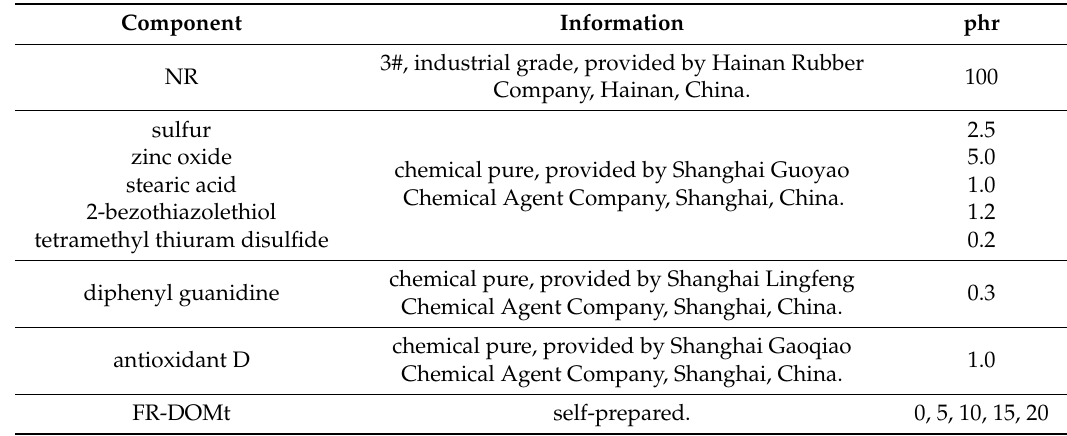
Table 1. Formulation of NR